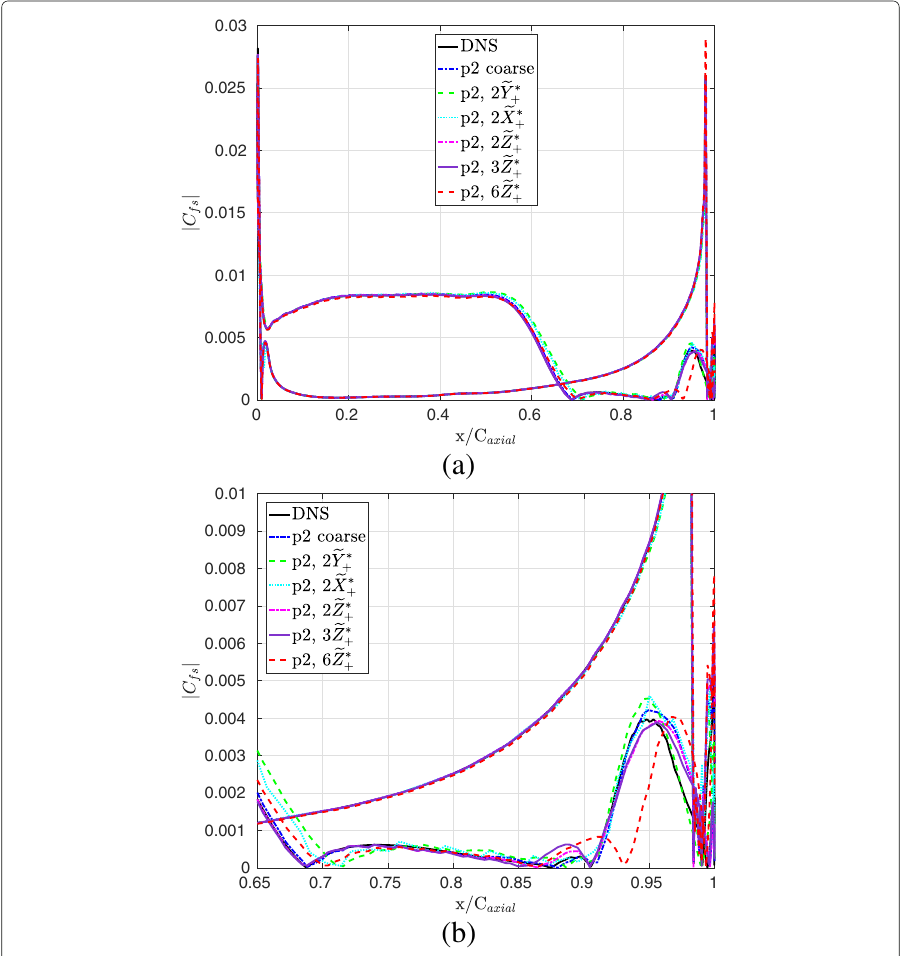
Fig. 11 Comparison of the time- and spanwise-averaged coefficient of streamwise friction for coarse LES simulations. Note that the starred resolution ( (cid:14) X ∗ + , (cid:14) Y ∗ + , (cid:14) Z ∗ + ) = ( 20,0.96,22 ) corresponds to the p2 coarse case. ( a ) global view over the blade ( b ) enlarged view near the trailing